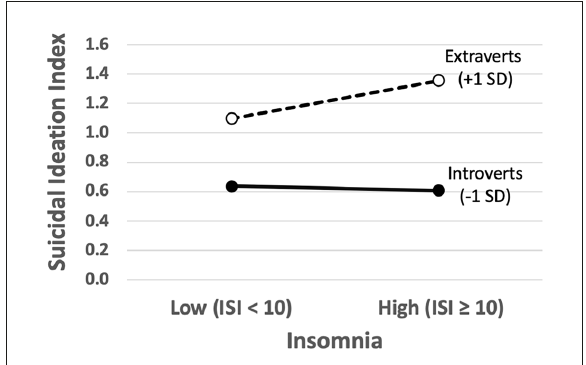
FIGURE2 The plot of the interaction effect (moderation) between insomnia category (low or high) and trait extraversion from the Eysenck Personality Inventory (EPI) on suicidal ideation scores from the composite Suicide Ideation (SI) index. ISI, Insomnia Severity Index; SD, standard